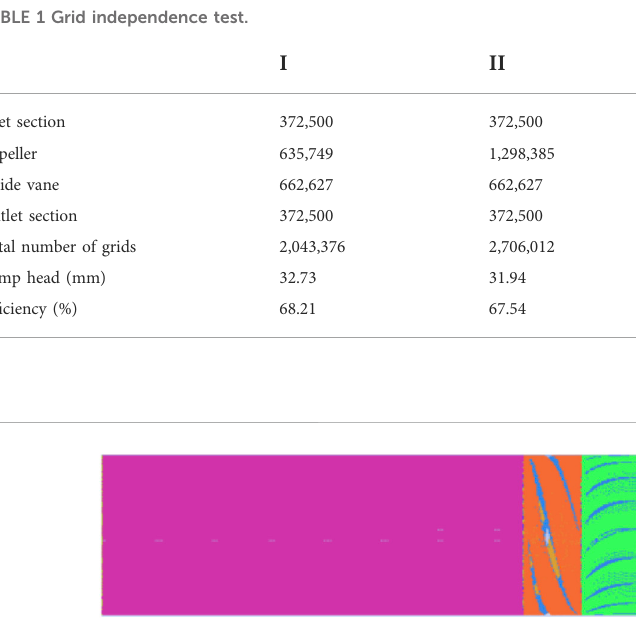
FIGURE 3 Calculation domain grid of the water body.